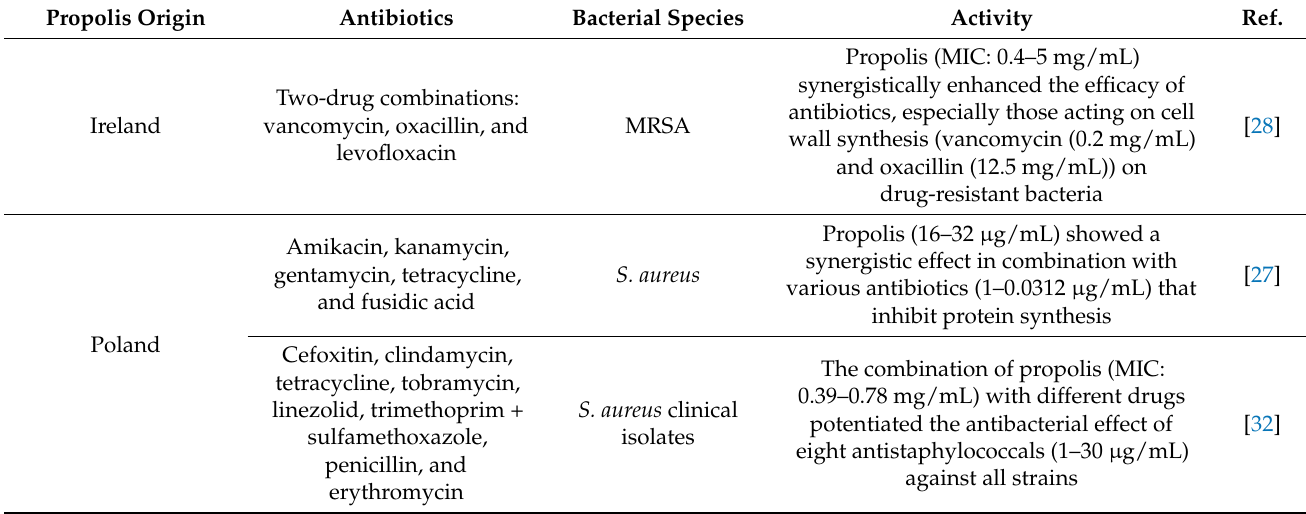
Table 3. Effects of propolis in combination with various drugs on different bacterial